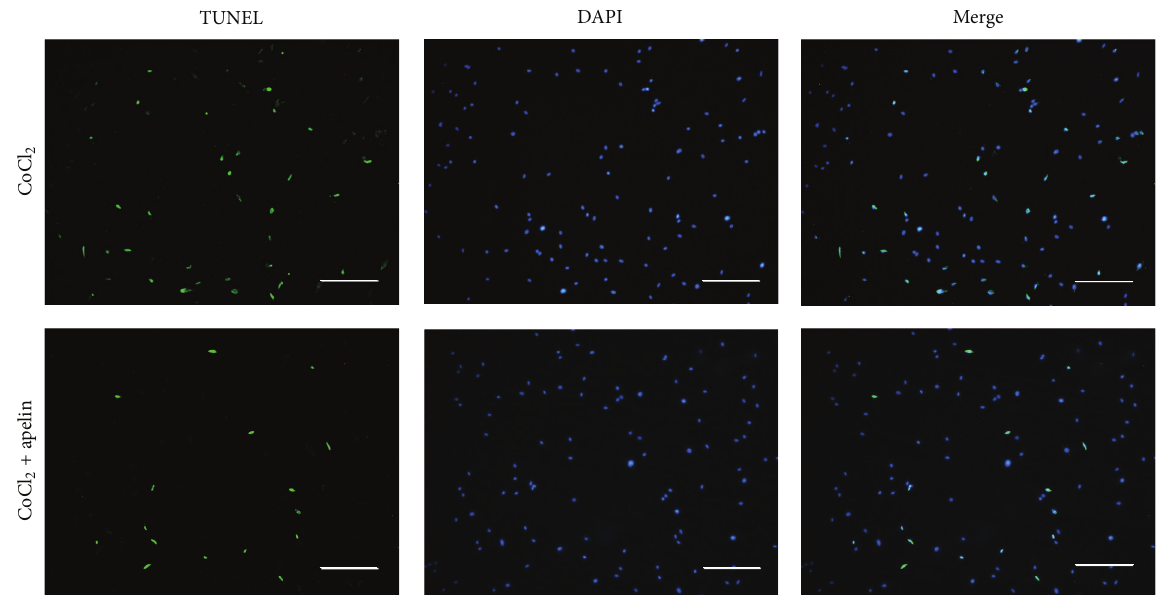
Figure 7: TUNEL staining was used to evaluate hypoxia-induced cell death. Cells were exposed to 100 ng/mL apelin for 12h and then exposed to hypoxia for 12 h. Apoptotic nuclei were visualized by TdT-mediated dUTP nick end-labeling (TUNEL). Scale bar = 200 𝜇 m.